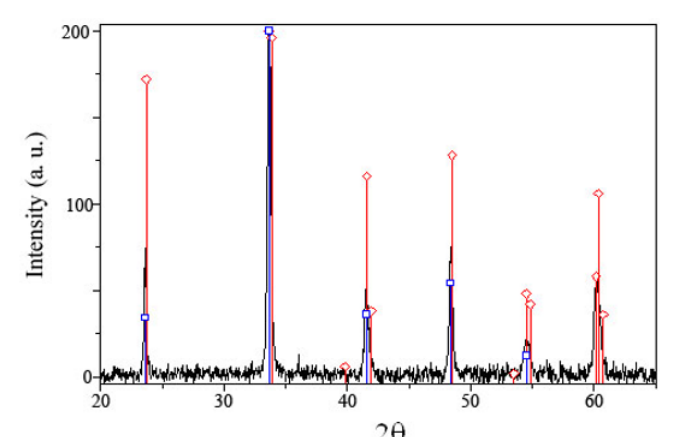
Figure 5. X-ray diffraction pattern of CoAlNdO ceramics synthesized using sol-gel method at 1000°C. Annealing time was 10 h. ◊ - reference 4 data for NdAlO